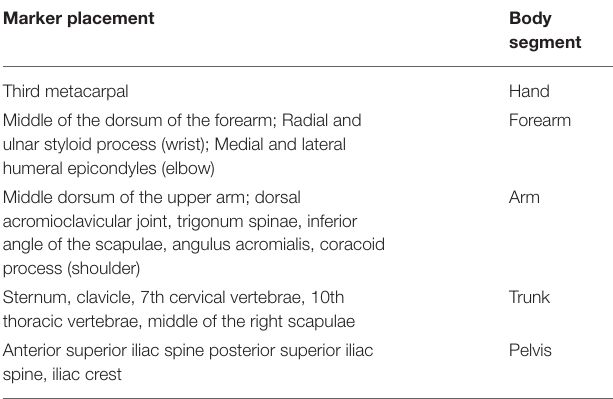
TABLE 2 | Anatomical locations of marker placements for kinematic sequence